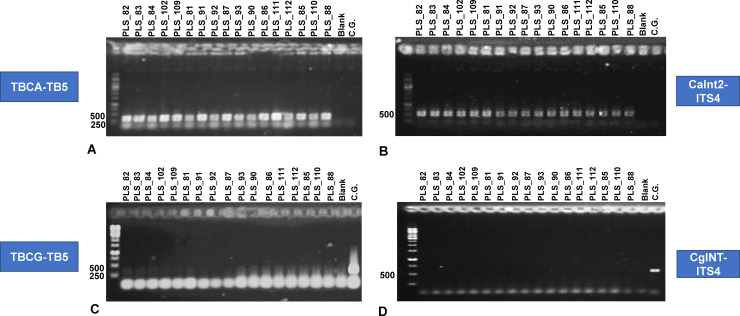
Agarose gel electrophoresis of PCR products following amplification with species-specific primers for Colletotrichum acutatum species complex and Colletotrichum gloeosporioides isolates.Products obtained using primers for the C. acutatum β-tubulin gene (forward primer: TBCA, reverse primer: TB5) (A) and the ITS region (forward: CaInt2, reverse ITS4) (B), and the C. gloeosporioides β-tubulin gene (forward primer: TBCG, reverse primer: TB5) (C) and the ITS region (forward: CgInt, reverse ITS4) (D), on 1% agarose gel.